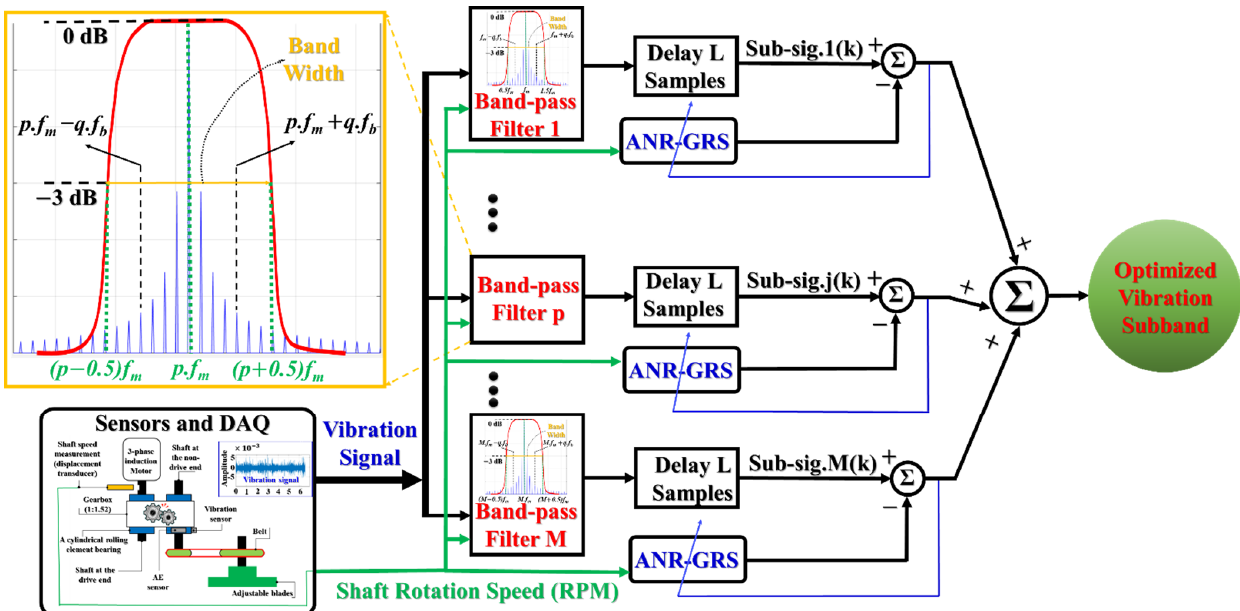
Figure 3. Block diagram of the LADT.